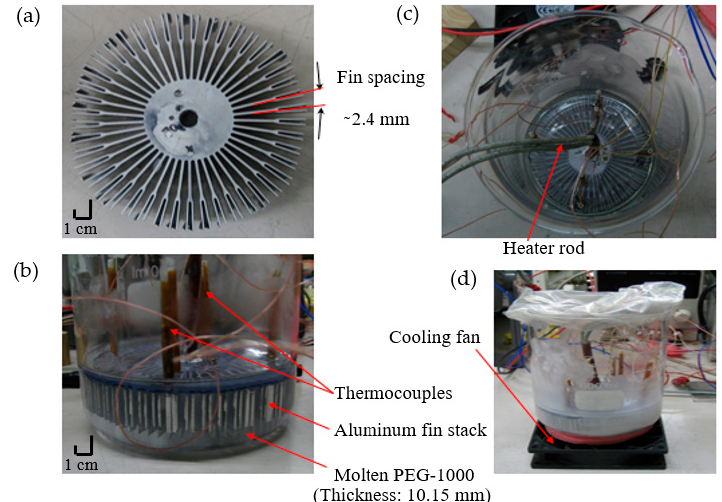
Figure 2. Experimental set-up for improving the thermal conductivity of the PCM using aluminum fins. ( a ) Aluminum fin stack; ( b ) Al fin stack suspended in PCM; ( c ) Al fin stack with heating arrangement; ( d ) Experimental set-up details.